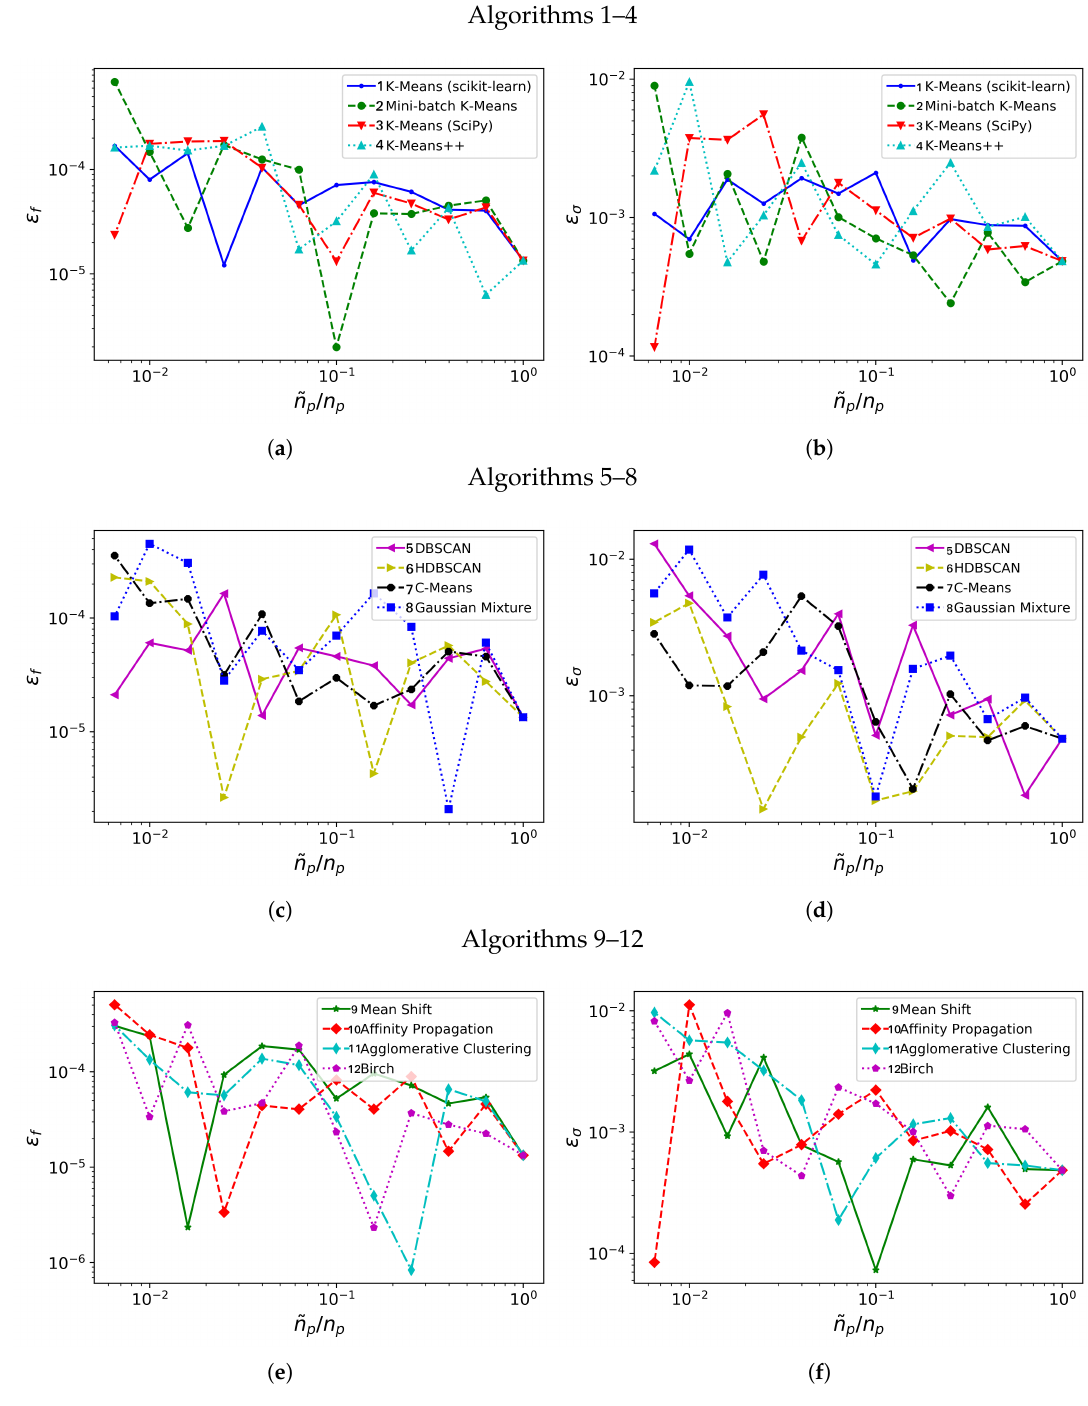
Figure 3. Synthetic system: Relative errors in frequency, ε f ( a , c , e ) and in growth rate, ε σ ( b , d , f ) with different clustering algorithms (1–4 in ( a , b ), 5–8 in ( c , d ), 9–12 in ( e , f